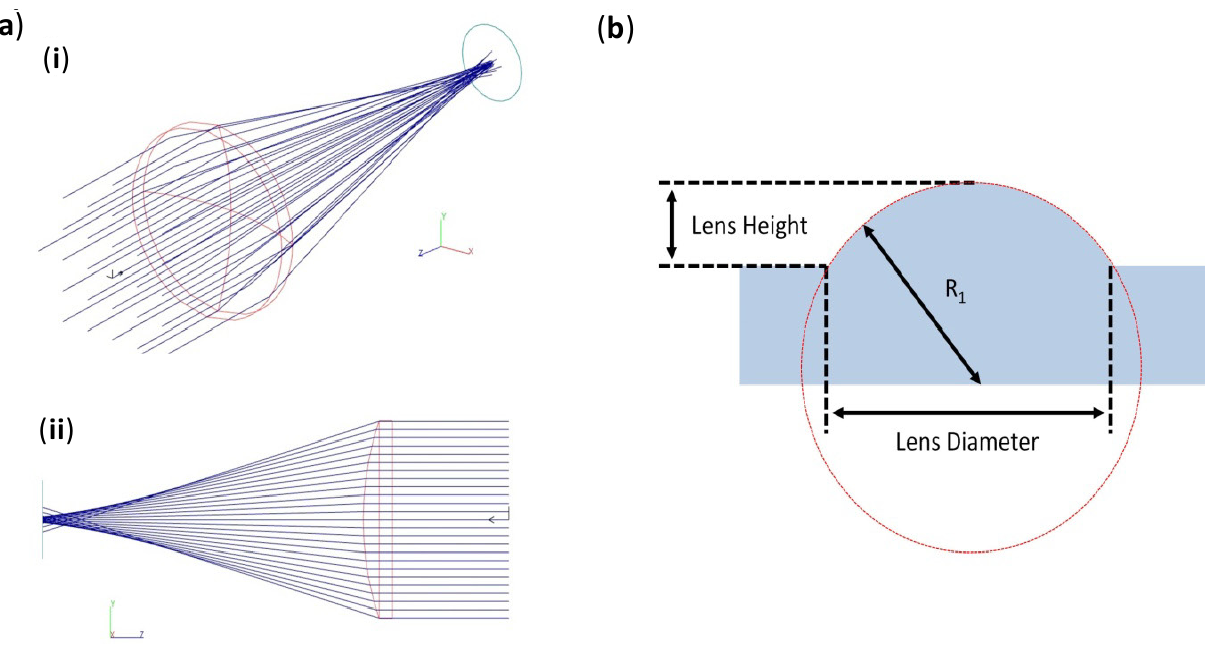
Figure 2. ( a ) Simulated results of the focusing of a collimated light source through a 5-mm plano-convex lens showing ( i ) 3D and ( ii ) a plan view of the lens and light rays; ( b ) A